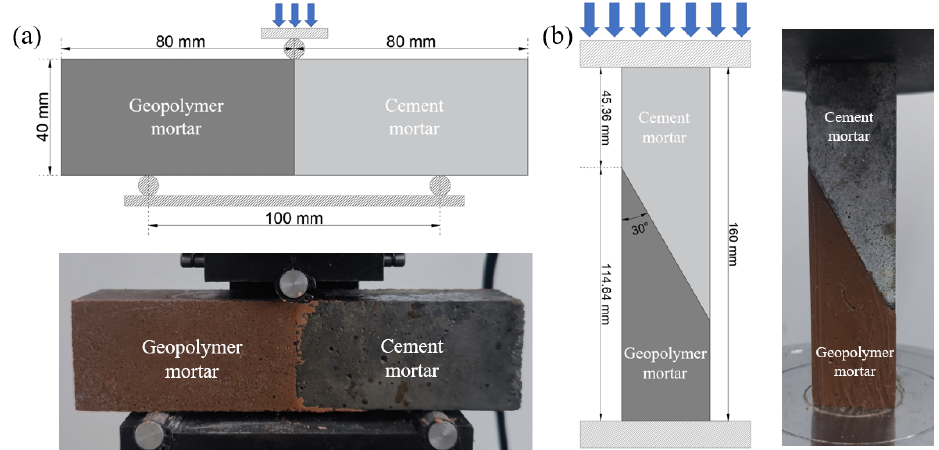
Figure 3. Schematic diagrams: ( a ) flexural bending strength test; ( b ) slant shear test.